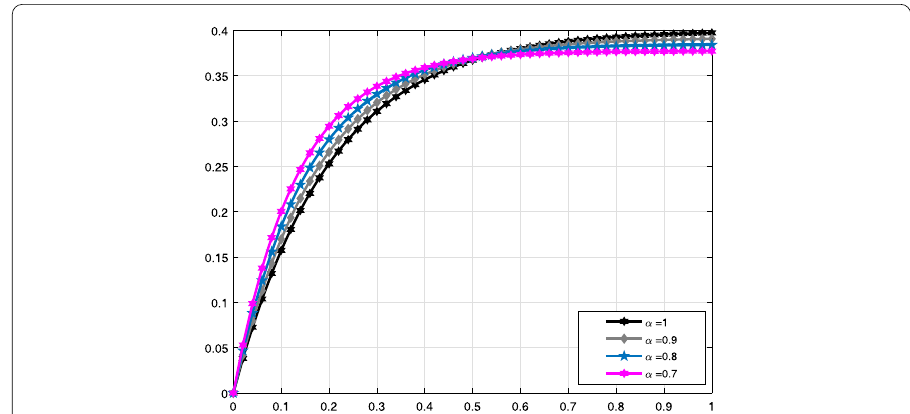
Figure 6 Comparative analysis with proportional derivative for V i ( t )